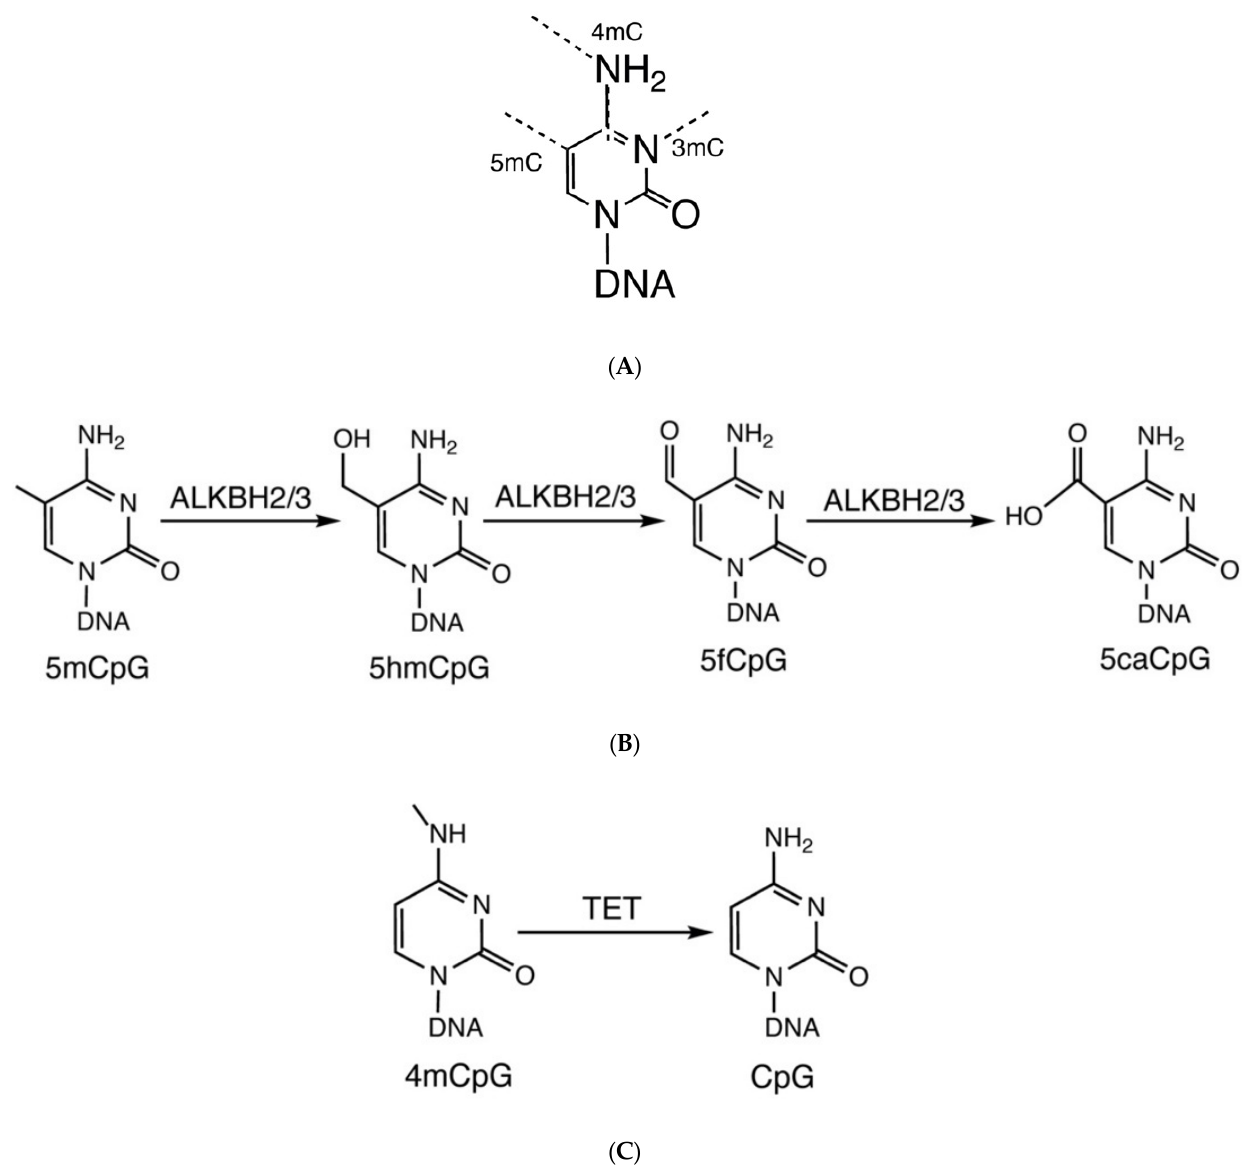
Figure 6. ( A ) Structure of a cytosine molecule where the methyl group is shown at positions 3, 4, 5 at the same time to demonstrate the proximity between these three methylated sites; ( B ) Schematic representation of oxidative demethylation of 5mC by ALKBH2,3 dioxygenases; ( C ) Schematic representation of direct demethylation of 4mC by TET family dioxygenases.